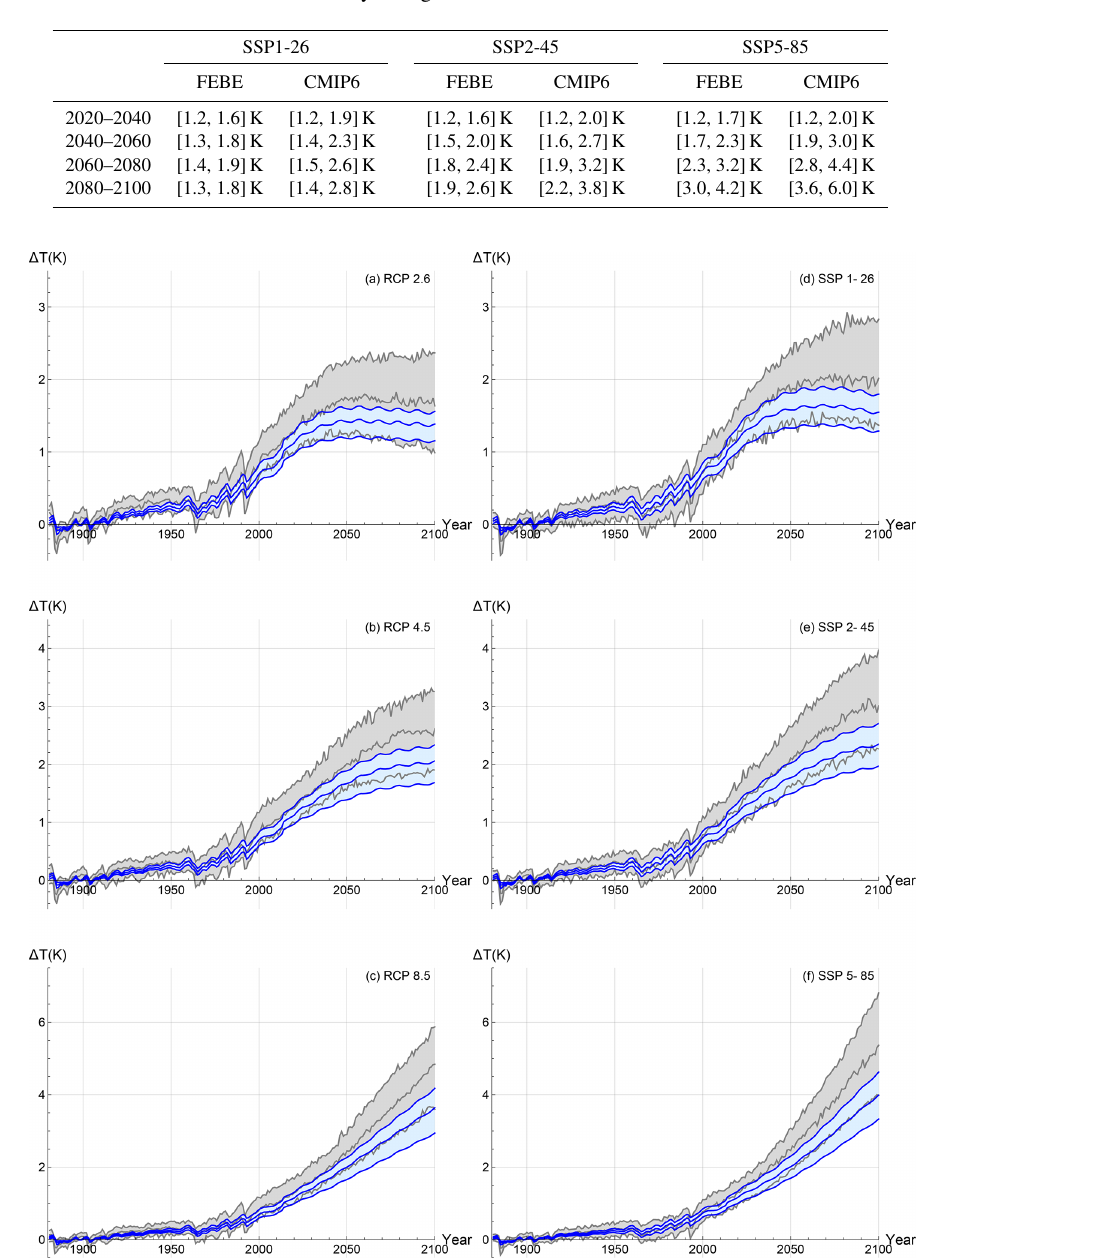
Table 5. The 90%CI of projected warming relative to the pre-industrial reference period (1880–1910) for the SSP scenarios analysed in this study based on the FEBE and the CMIP6 MME. Summary of Fig. 12d–f.